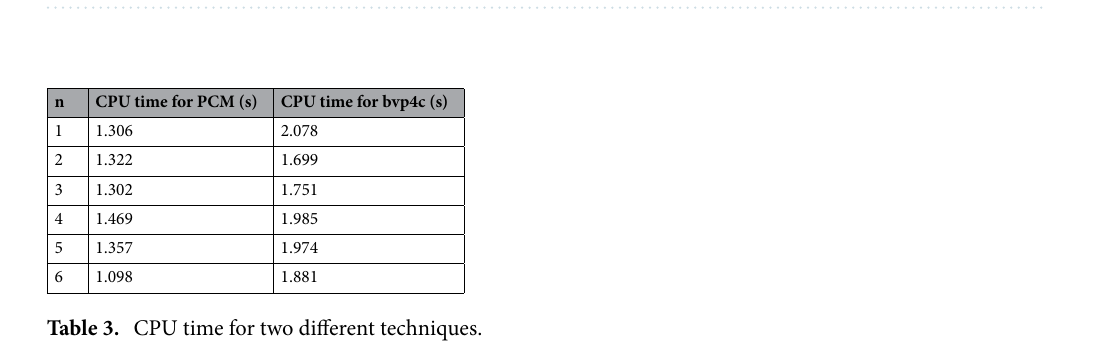
Table 2. Comparison of the present result with previous published work, when Ec = f w = (cid:31) = 0 and for present work ϕ = K = R = Gr = Gc = 0 .